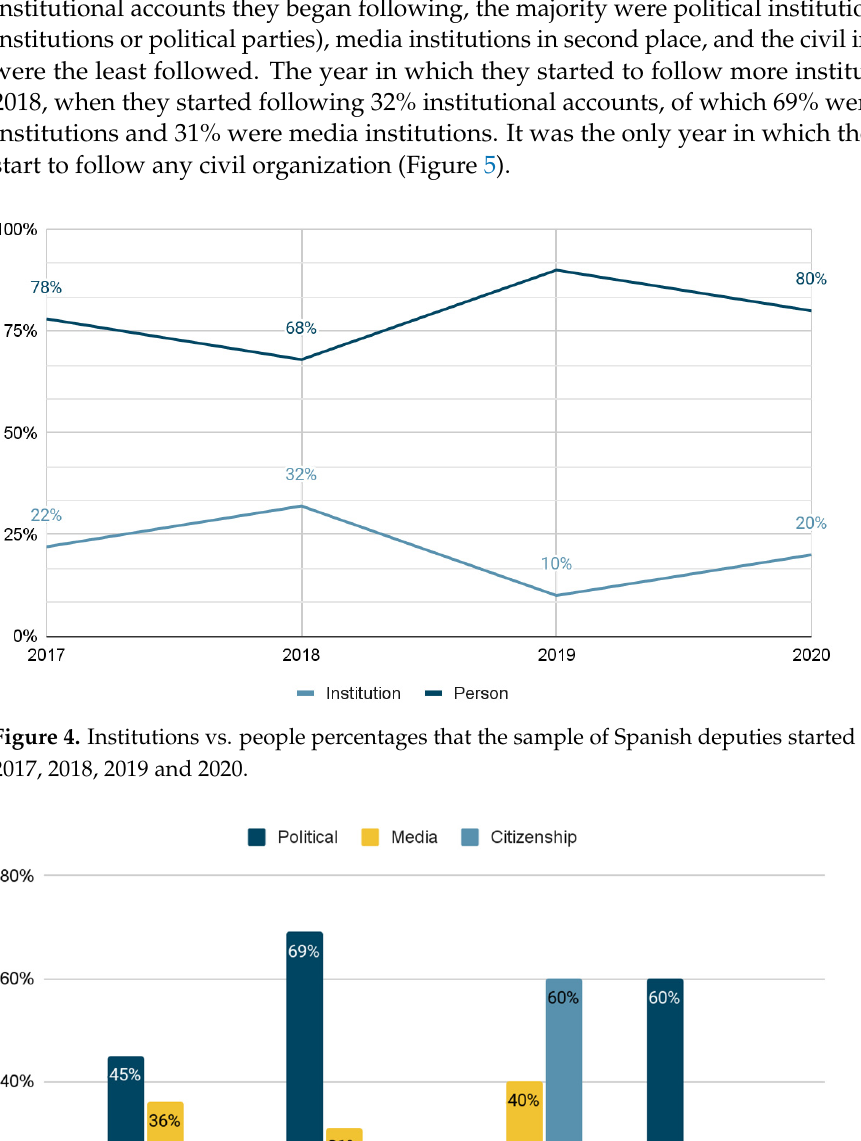
Figure 6. Percentages of Spanish accounts or those from other countries that the sample of Spanish deputies started to follow in 2017, 2018, 2019 and 2020. 3.4. Number of Followers Most of the accounts that the analyzed Spanish deputies began following had between 10,001 and 100,000 followers, categorized as mid-influencers. This trend was especially high in 2018 and the pattern in all the years of the study, except in 2017, when we found almost the same number of micro- and mid-influencers, with one more account of micro-influencers. The Spanish deputies began following a similar number of accounts from micro- and macro-influencers, with one more account belonging to the micro-influencers. In the fourth place, they began following icon-influencers and the non-influencers were the group least followed by the sample. (Figure 7).